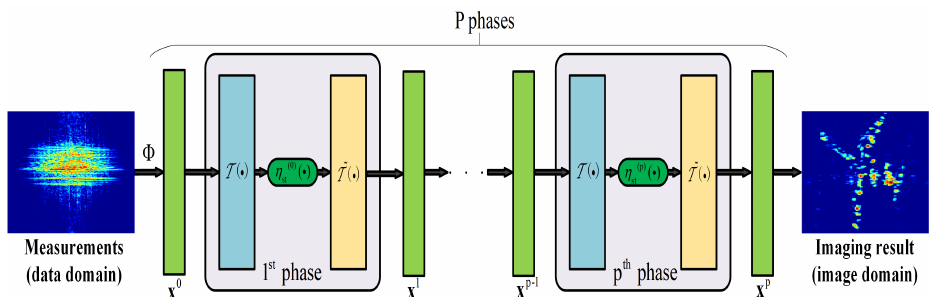
Figure 2. Convolution iterative shrinkage-thresholding (CIST) network in K th phase.